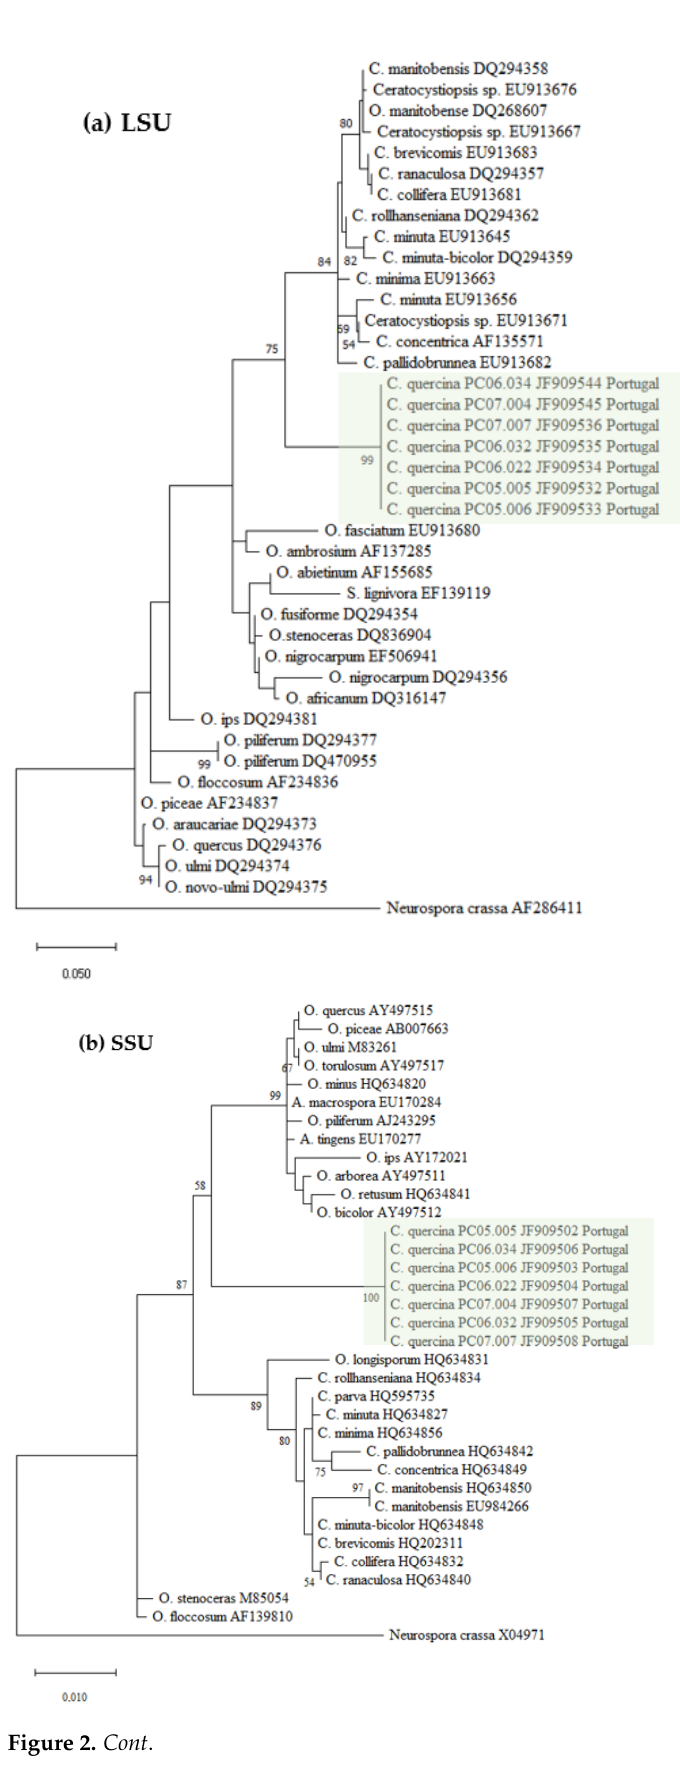
(Table 1). The first aligned dataset (Figure 2a), contained LSU 28S rDNA sequences of Ceratocystiopsis species and related species in closely related genera (451 characters, 82 parsimony informative). The second alignment (Figure 2b), contained SSU 18S rDNA se- quences (1024 characters, 51 parsimony informative). For the phylogenetic analysis of the 5.8S-ITS2-28S region (Figure 2c), the alignment had 311 characters, including gaps, of which 116 were parsimony informative. The fourth alignment (Figure 2d), contained the β -tubulin (TUB) sequences (242 characters, 133 parsimony informative).